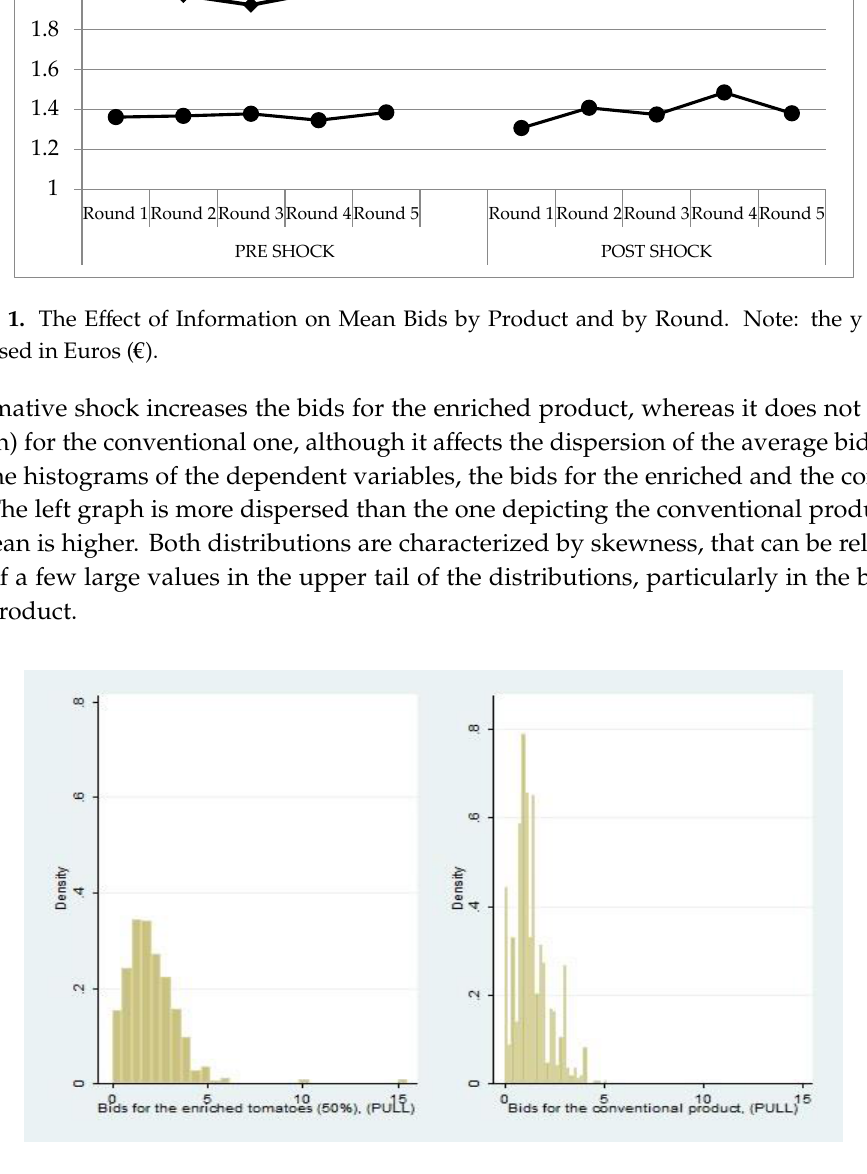
Figure 2. Empirical distributions of bids for the enriched and the conventional product.